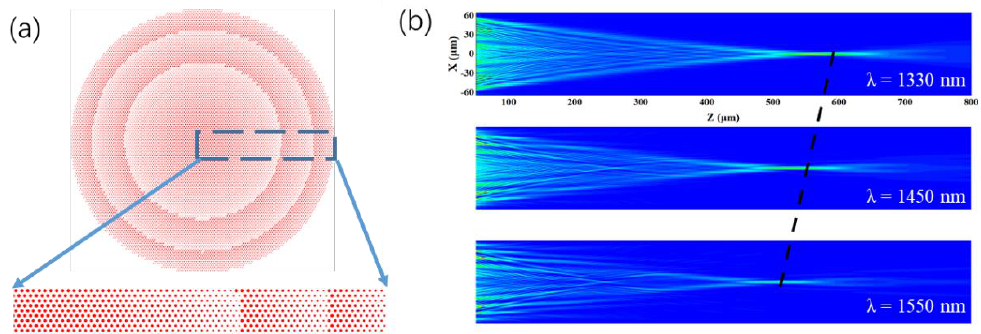
Figure 3. ( a ) The nanostructured layout of the designed single-band metalens; ( b ) the lateral optical intensity distributions at 1330 nm, 1450 nm, and 1550 nm. intensity distributions at 1330 nm, 1450 nm, and 1550